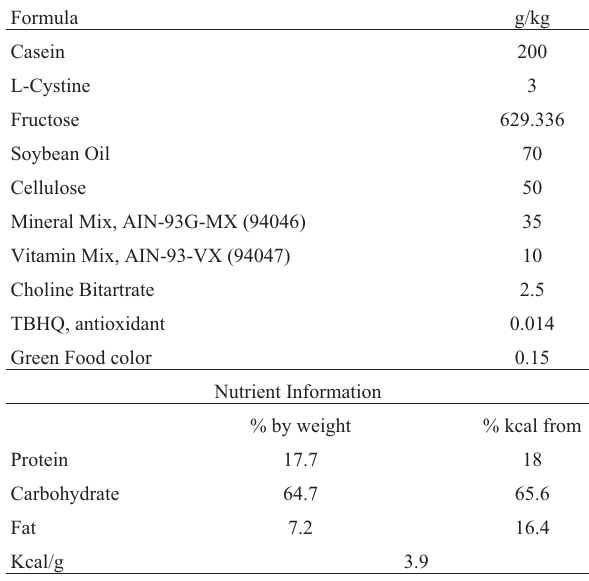
Table 4 - 63% Fructose Diet: TD.06702 AIN-93G